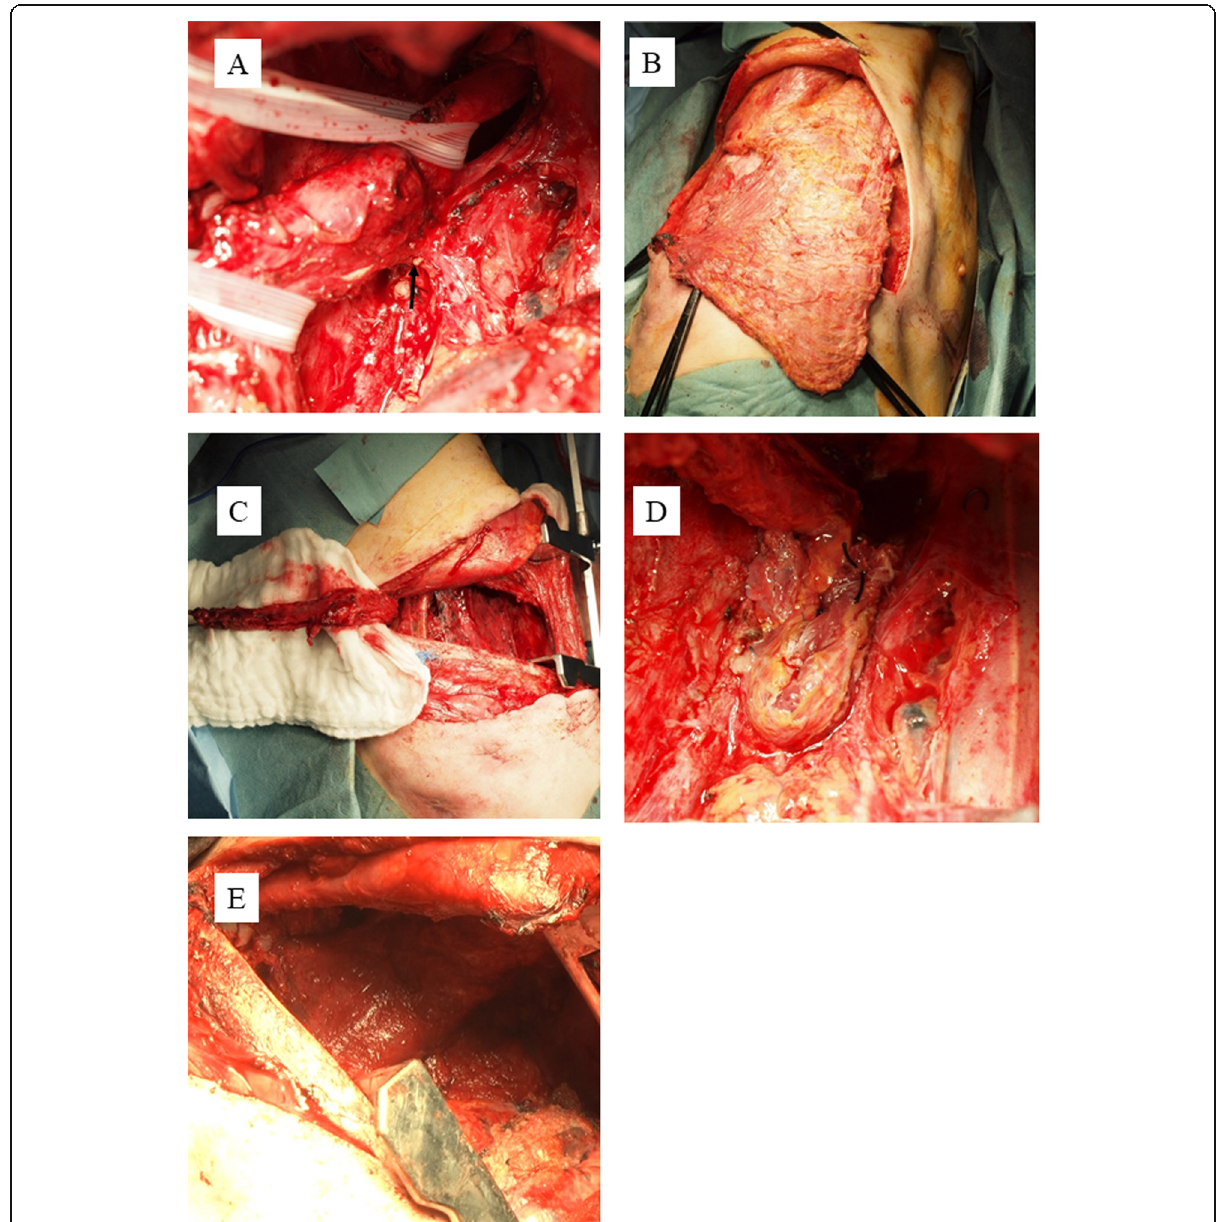
Fig. 3 We separated the anastomosis from the trachea. An upper Penrose drain was placed in the esophagus, and a lower Penrose drain was placed in the gastric conduit. The GTF was visualized between the trachea and the gastric conduit (black arrow) ( a ). The latissimus dorsi muscle flap was constructed ( b ). The intercostal muscle flap was constructed ( c ). After incision of the GTF, direct sutures were used to close the fistula, which was then covered using the intercostal muscle flap ( d ). The latissimus dorsi muscle flap covered the area above the intercostal muscle flap ( e